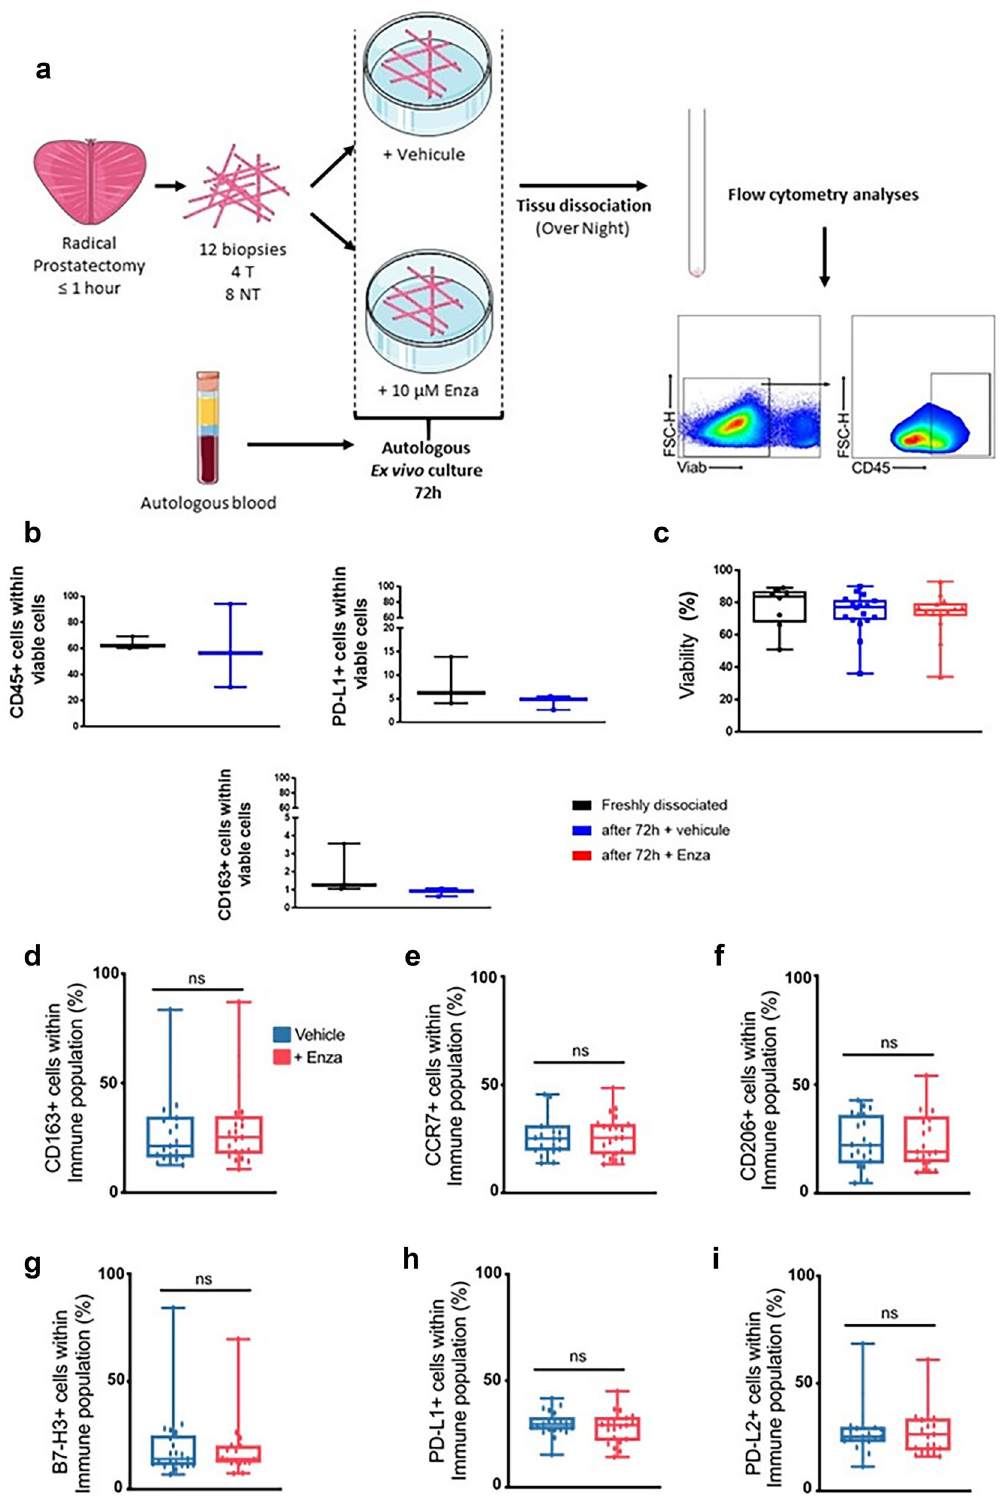
Figure 2. Ex vivo short-term culture and treatment of prostate cancer biopsies with enzalutamide A schematic of biopsy processing and gating strategy for CD45 immune cells is shown ( a ). Comparison of CD45, PD-L1 and CD163 expression of paired biopsies freshly dissociated and after 3 days of culture (n = 3) ( b ). Comparison of cell viability in freshly dissociated biopsies (n = 8) and treated or control biopsies cultured for 72 h (n = 14) ( c ). Evaluation of M1-associated marker (CCR7), M2-associated marker (CD163, CD206) and immune checkpoints (B7-H3, PD-L1, and PD-L2) within total immune cell population between treated and control-treated paired- samples ( d – i ). n = 21, paired and non-paired Student’s T-test, ns = statistically not